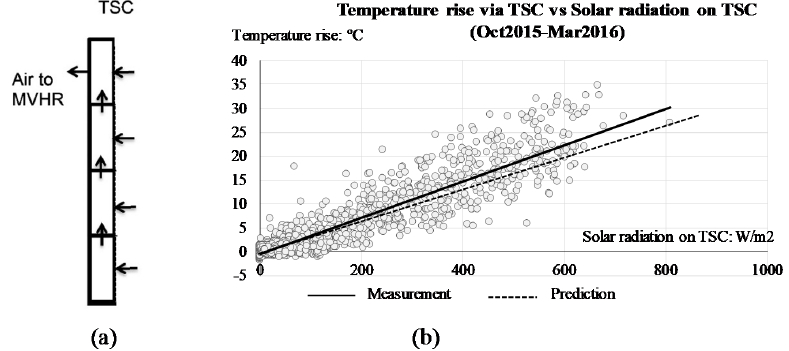
Figure 5. ( a ) Schematic of the TSC submodel; ( b ) Temperature rise between the external air temperature and the TSC outflow, against solar radiation incident on the TSC panel. Measured data is from October 2015 to March 2016 (grey markers and trend line); predicted data (dotted black trend line).